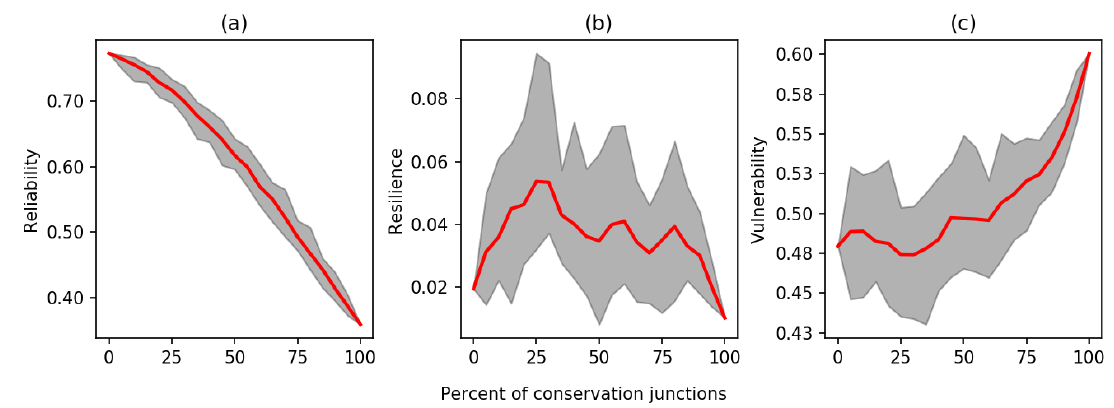
Figure 8. Network performance with the gradual adoption of conservation strategies using WUDESIM: ( a ) reliability; ( b ) resilience; ( c ) vulnerability.